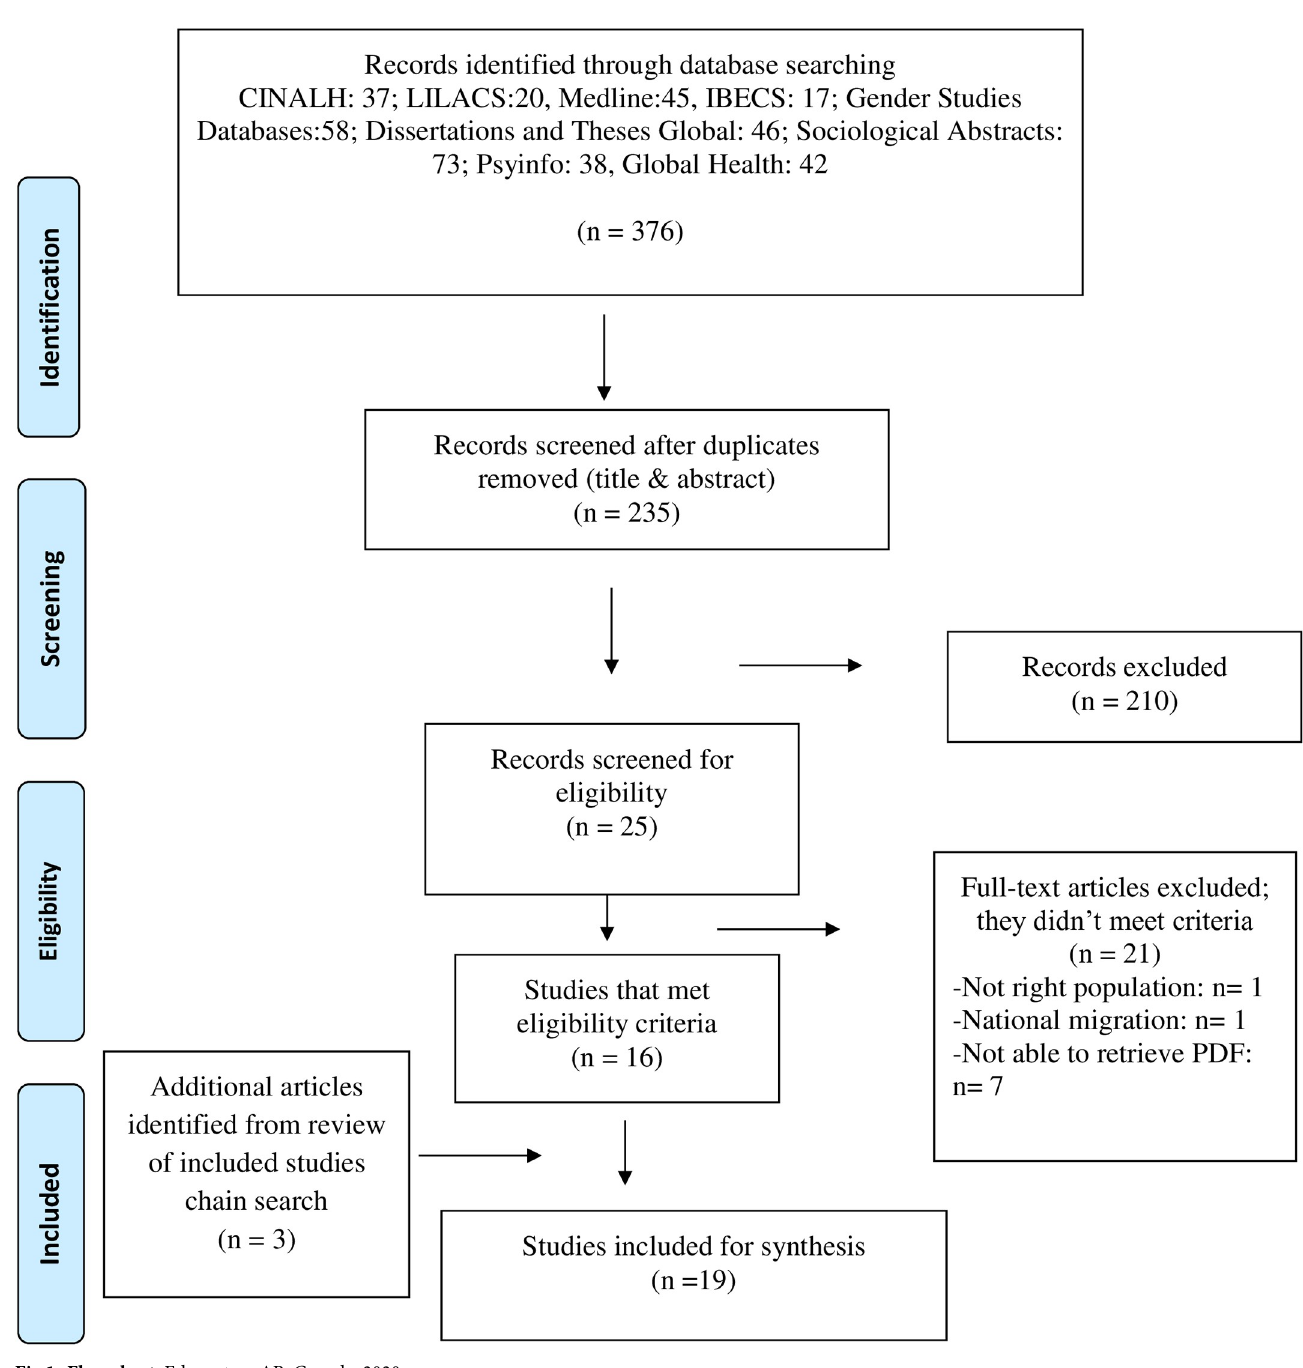
Fig 1. Flow chart. Edmonton, AB, Canada,